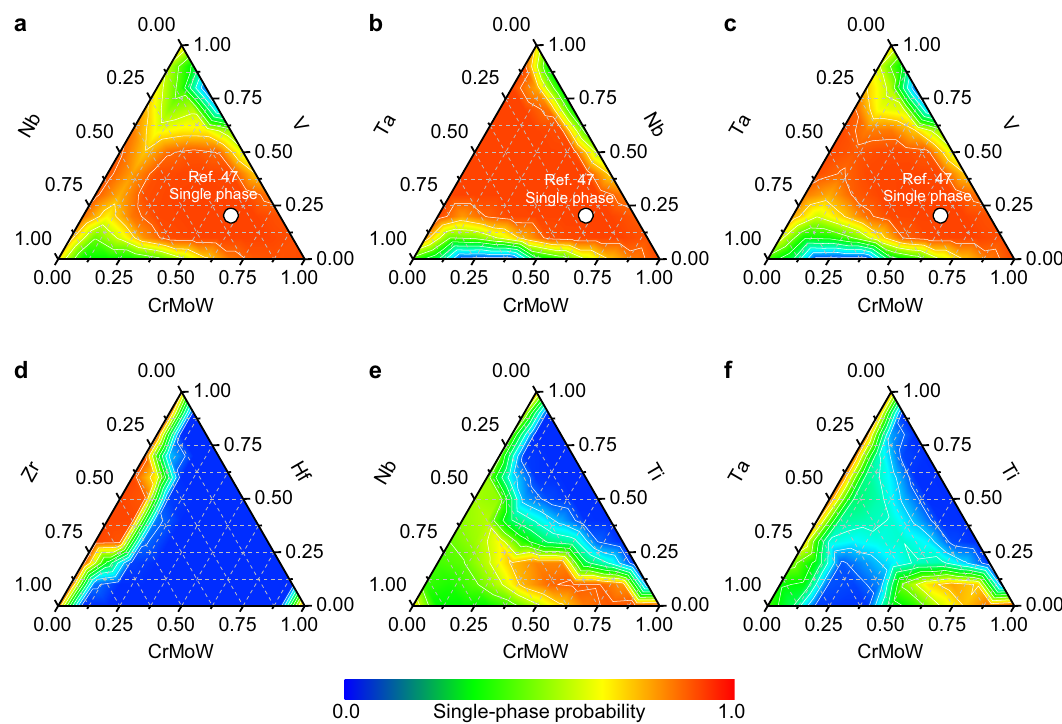
Fig. 7 Phase diagrams of (CrMoW)-based HECCs from ML. a (Cr, Mo, Nb, V, W)C 5 . b (Cr, Mo, Nb, Ta, W)C 5 . c (Cr, Mo, Ta, V, W)C 5 . d (Cr, Hf, Mo, W, Zr)C 5 . e (Cr, Mo, Nb, Ti, W)C 5 . f (Cr, Mo, Ta, Ti, W)C 5 . Numbers in each axis denote the atomic percentages in the cation sublattice. Three elements are included in the horizontal axis with equiatomic ratios. Scattered data with circular labels are results from ref. 47 .